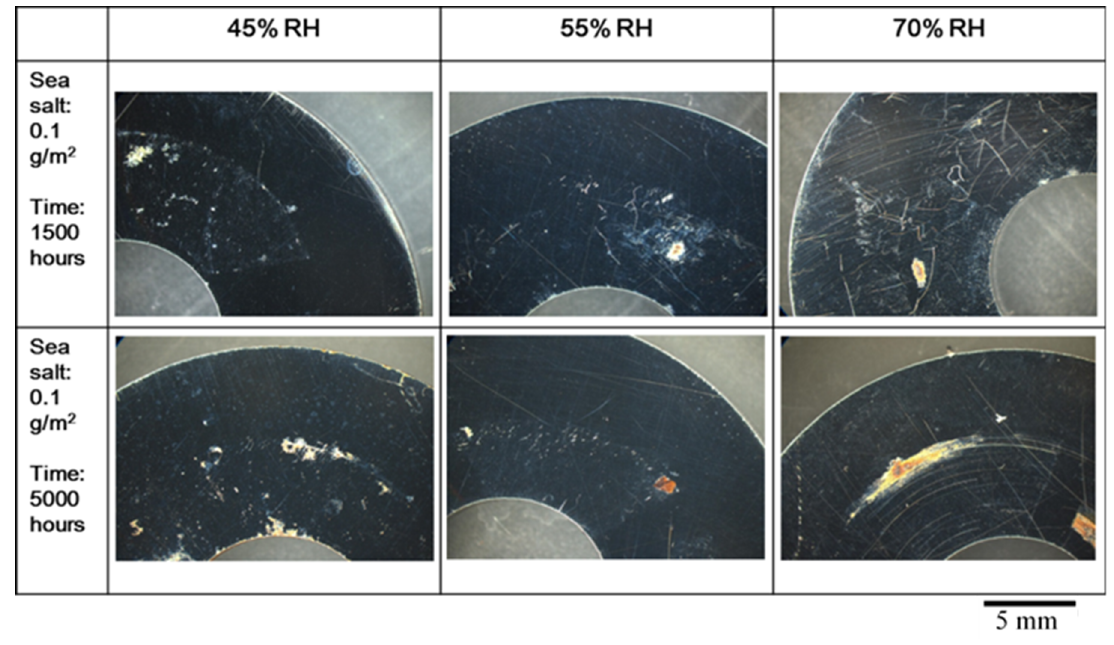
Figure 3. The specimens with 0.1 g/m 2 of sea salt deposited on the surface were tested at different relative humidity levels and temperatures of 45 °C.